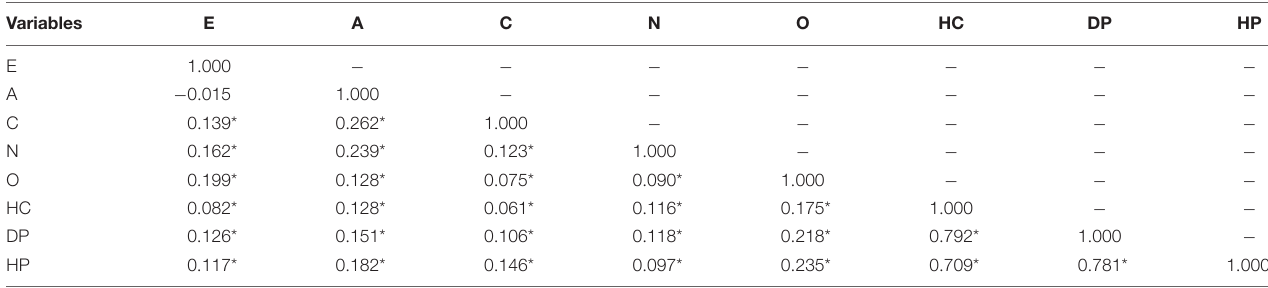
TABLE 4 | Correlation matrix for the variables of health literacy and personality traits.